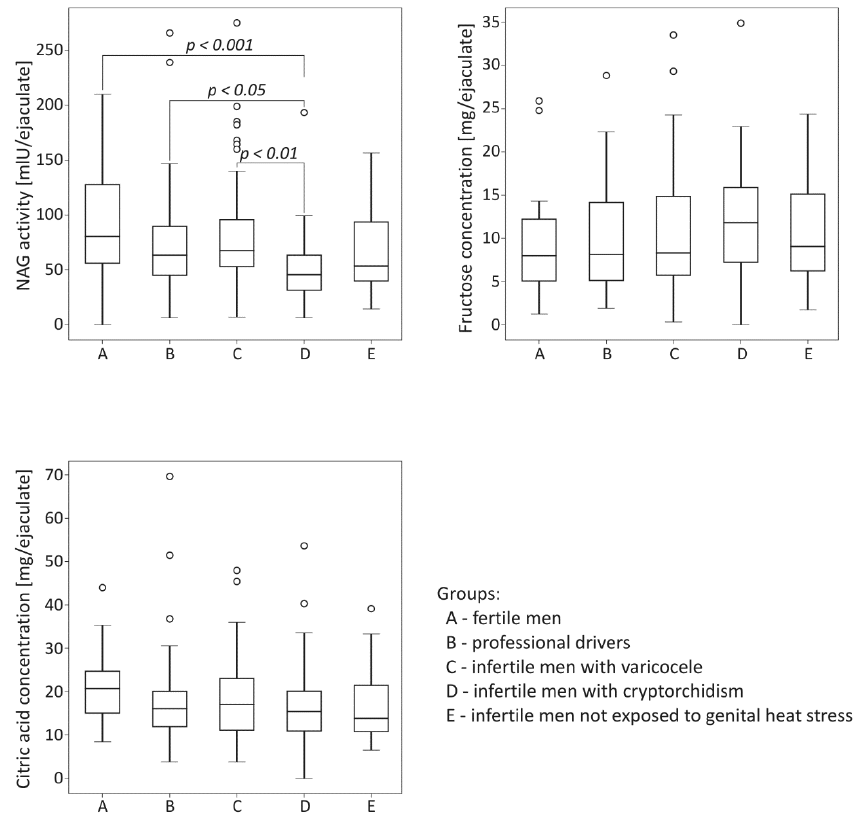
Figure 1. Comparison of seminal neutral alpha-glucosidase (NAG) activity, fructose concentration and citric acid concentration among the studied groups. The results are expressed as the median, Q1–Q3, and range. p < 0.001 calculated using the Dunn test with Holm’s correction compared to the control group; p < 0.01, p < 0.05, calculated using the Dunn test with Holm’s correction compared to the group with cryptorchidism. ◦ —data points with values greater than Q3 + 1.5 × interquartile